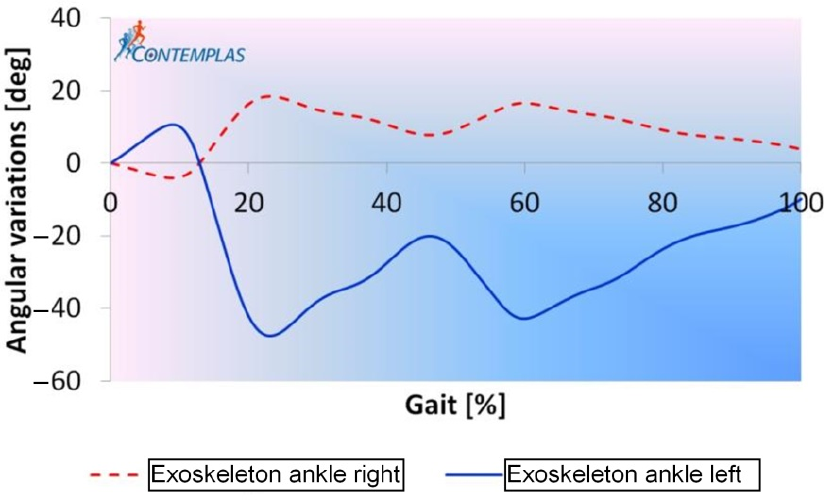
Figure 29. Exoskeleton ankle joints angular variation for a complete gait without foot and ground contact.